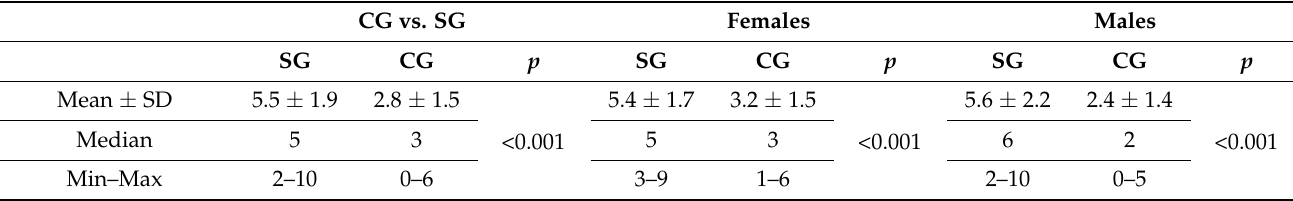
Table 4. Differences in the incidence of the total value of CVD risk factors.